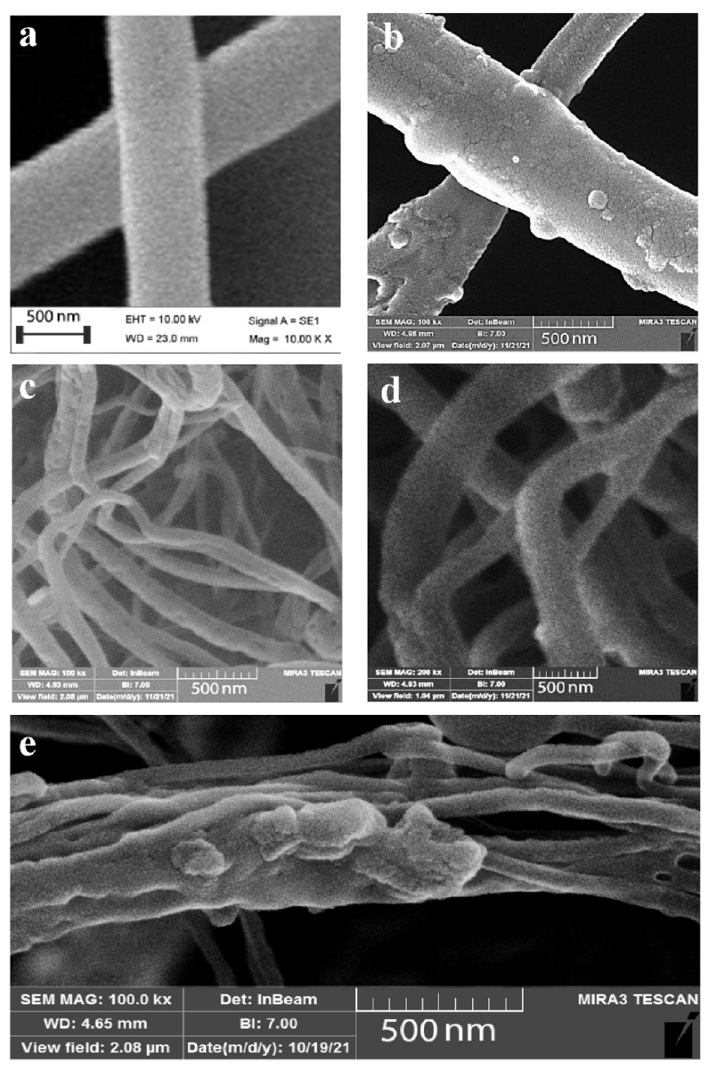
Figure 2. Blow spun nanofibers by gelatin ( a ), Gel/SNPs ( b ), PLA ( c ), PLA/SNPs ( d ) and PLA/Gel /NPs ( e ) solutions.